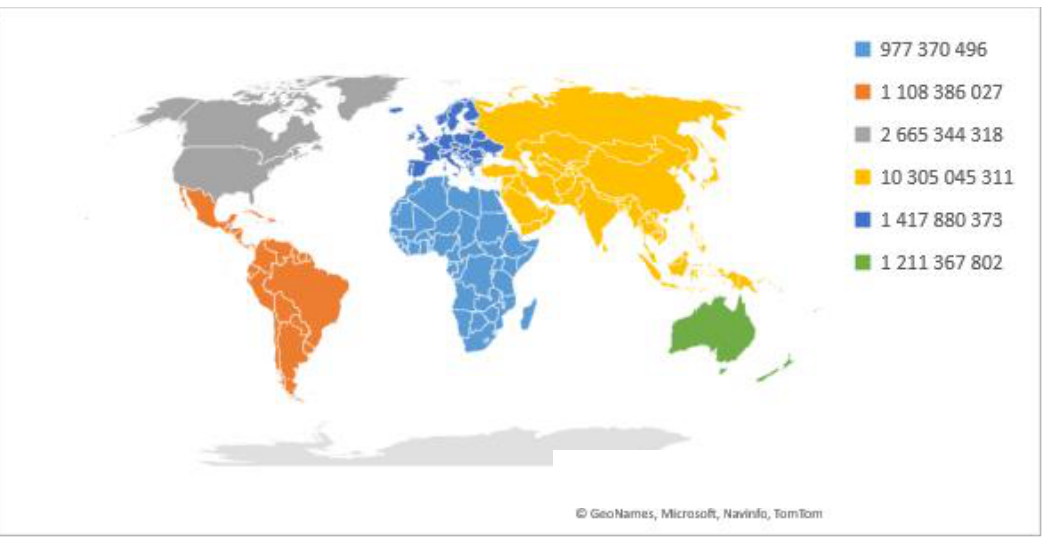
Figure 1. Total mining productions by continents in 2018 in tons (developed on the basis of data available in the World Mining Data database. (World Mining Data provides an indispensable basis for commodity forecasts and activities in minerals policy at national and European level; it contains production of mineral commodities listed in detail by continents, country groups, development status, per capita income, economic blocks, political stability of producing countries, largest producers and others. The data are available online: https://www.world-mining-data.info/ (accessed on 13 July